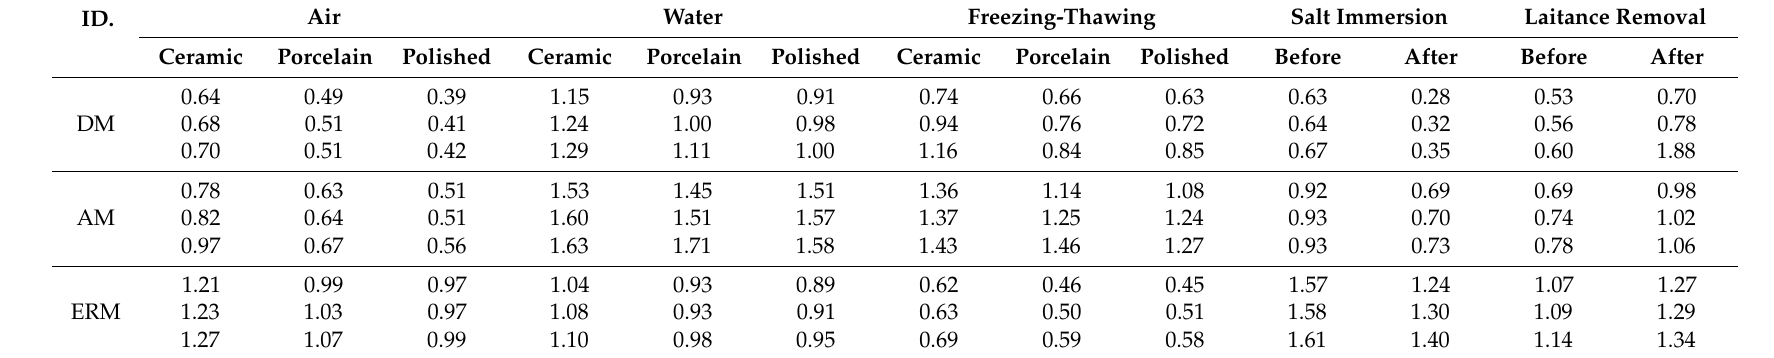
Table 3. Details of adhesive